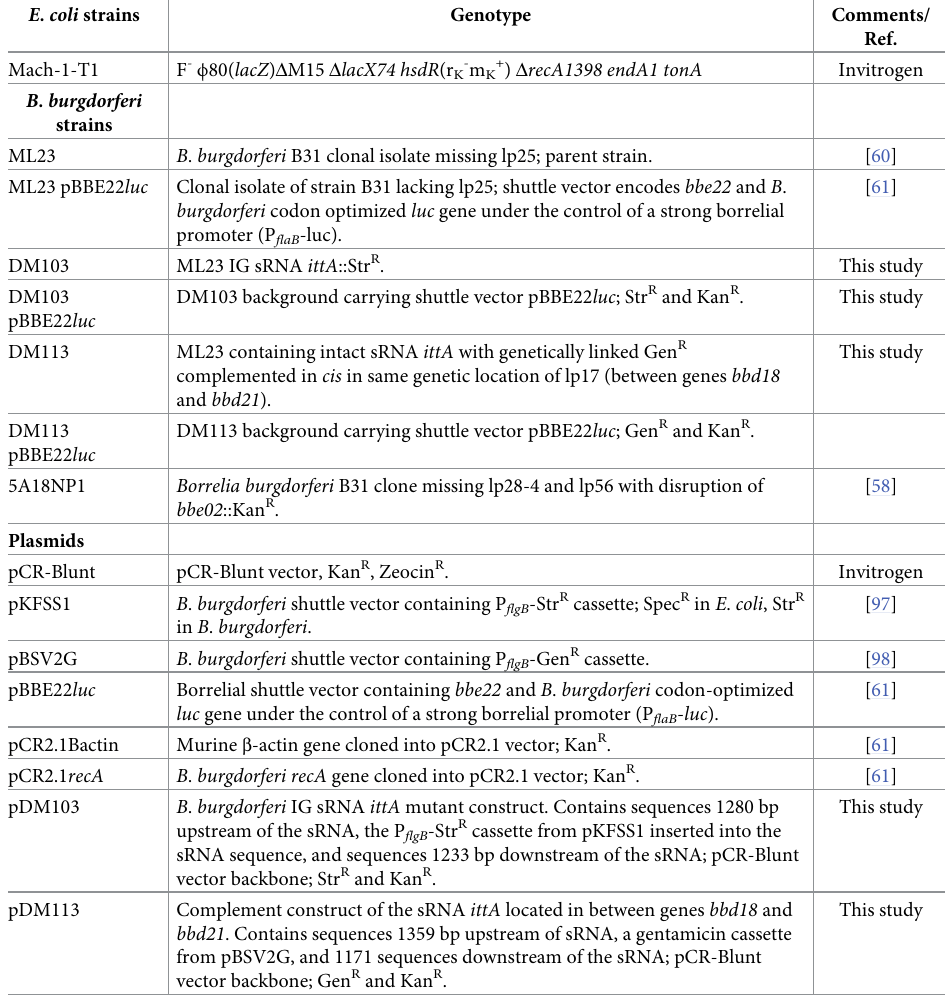
Table 4. Plasmids and strains used in this